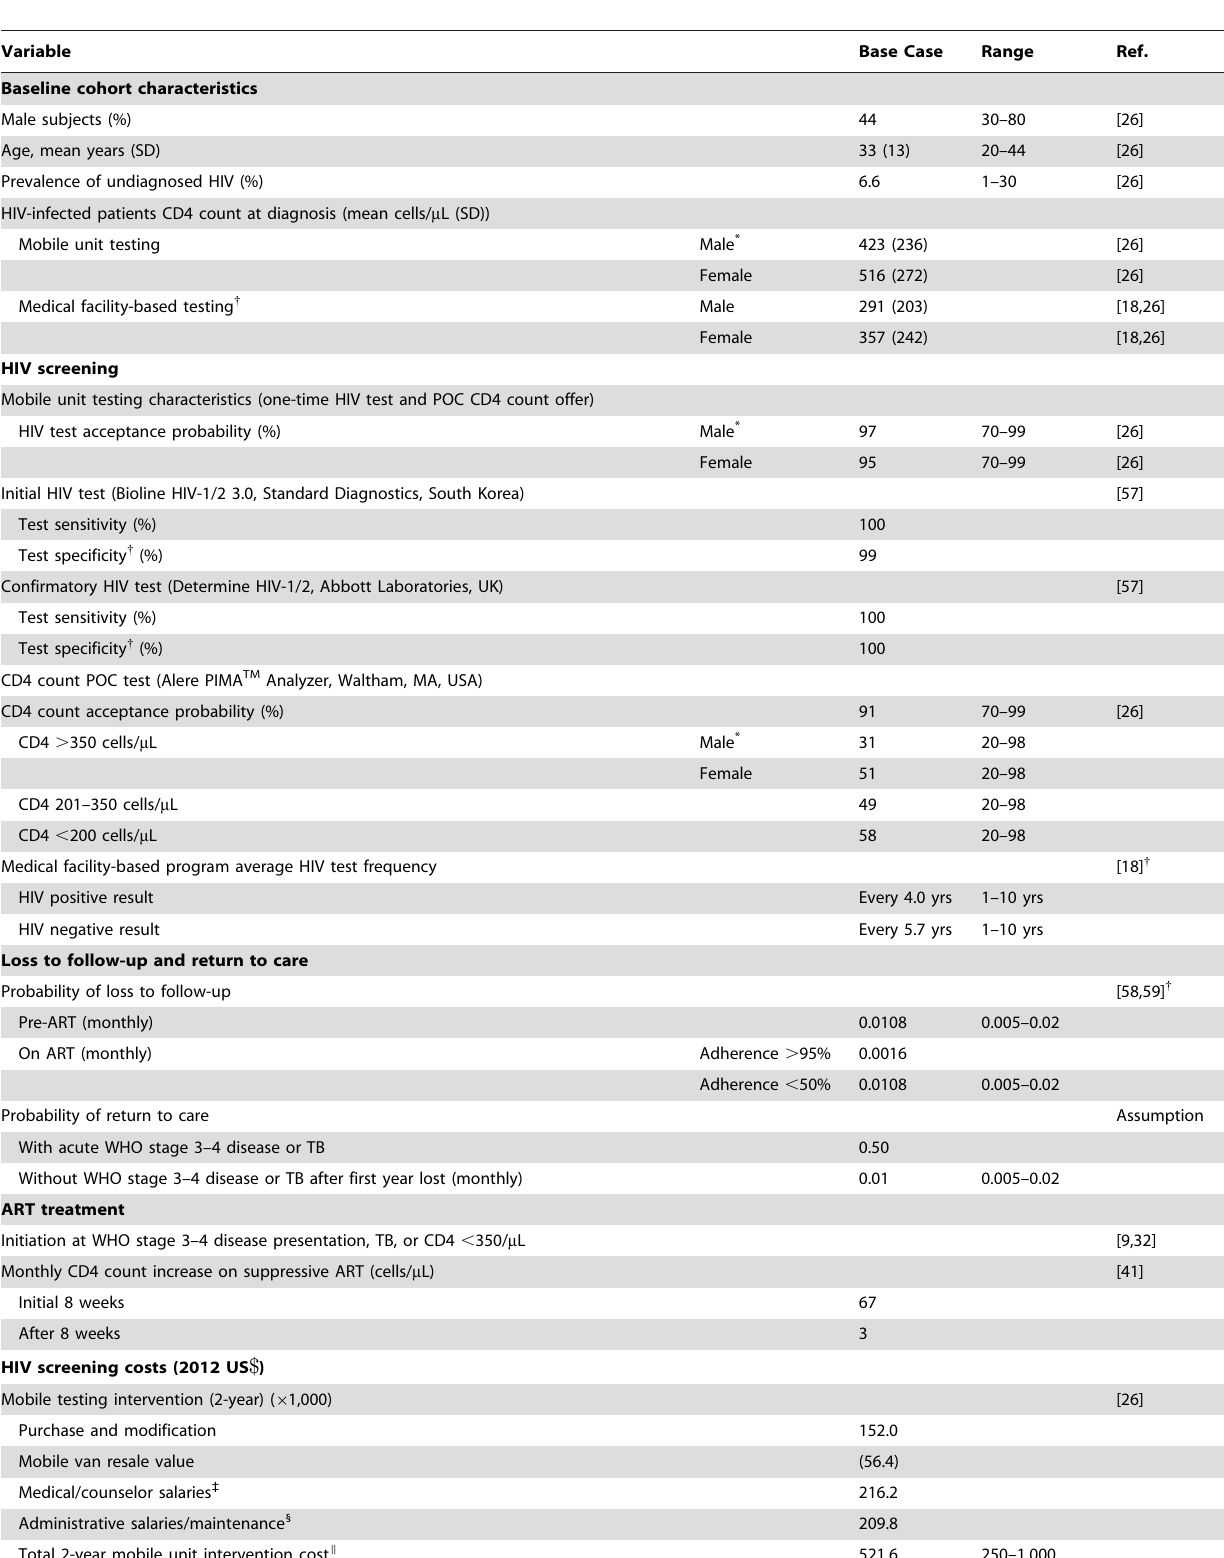
Table 1. Summary of base case input parameters and sensitivity analyses ranges examined for an analysis of a mobile HIV testing unit Cape Town, South